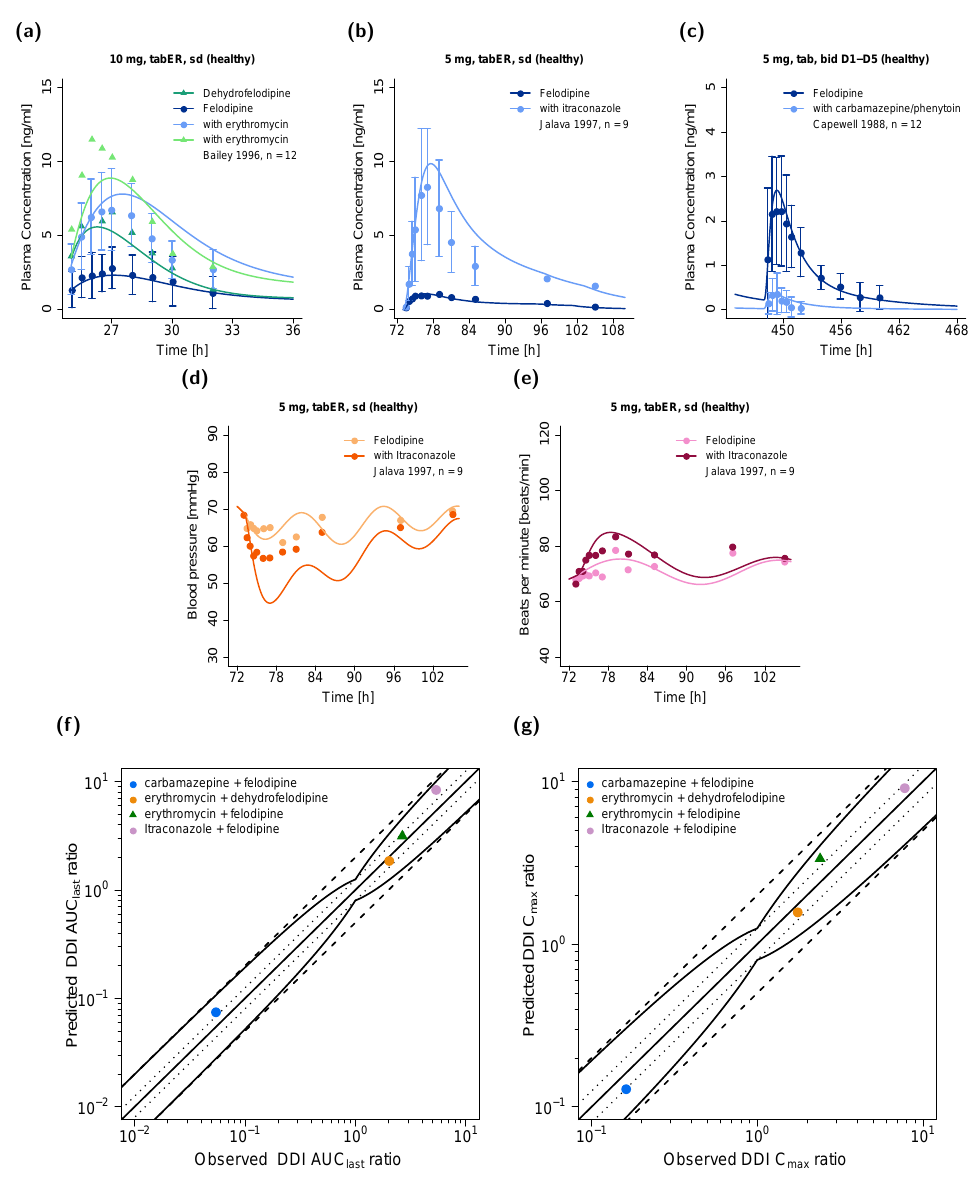
Figure 5. Upper row: predicted felodipine plasma concentration–time profiles with and without co-administration of the perpetrators ( a ) erythromycin, ( b ) itraconazole, and ( c ) carbamazepine and phenytoin in comparison to observed data [13–15]. Center row: predicted ( d ) diastolic blood pressure and ( e ) heart rate–time profiles with and without co-administration of itraconazole in comparison to observe data. Lower row: goodness-of-fit plots of predicted versus observed ( f ) DDI AUC last ratios and ( g ) DDI C max ratios. AUC last : area under the plasma concentration − time curve from the time of dosing to the time of last concentration measurement, bid: twice daily, C max : maximum plasma concentration, D: day, DDI: drug–drug interaction, n: number of individuals, sd: single dose, tab: tablet, tabER: extended-release